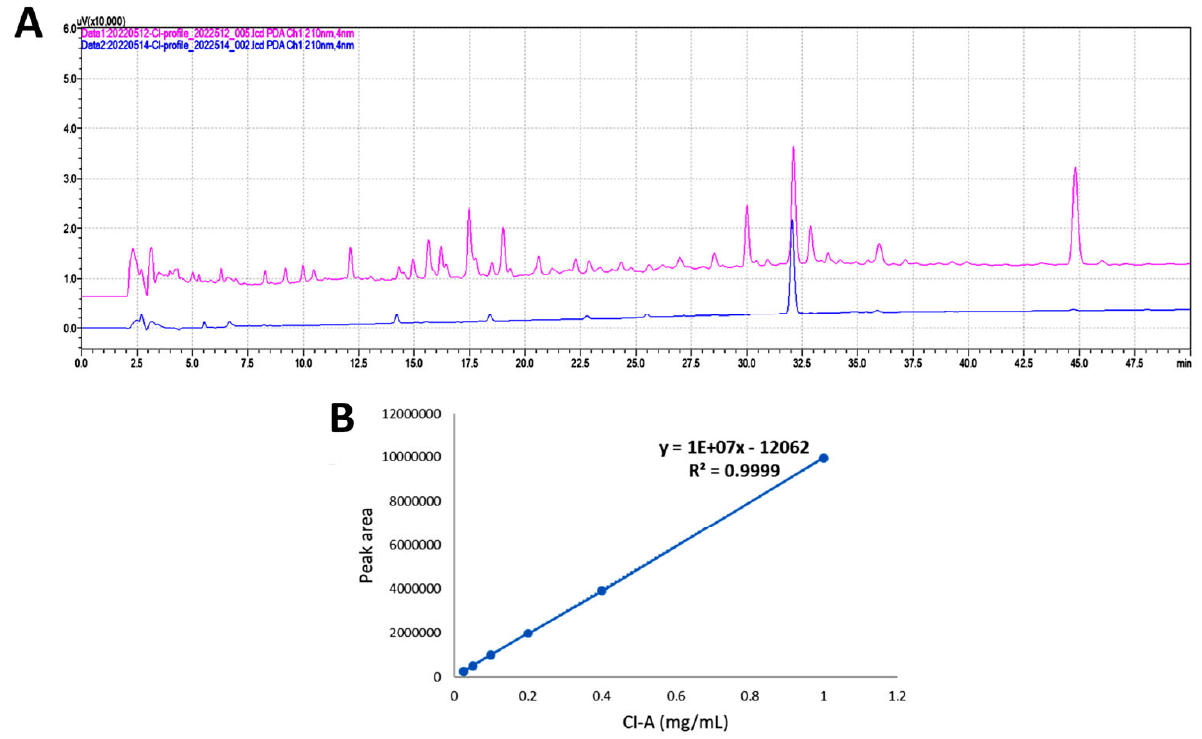
Figure 1. HPLC profile of MECI and major component. ( A ) The HPLC-UV (210 nm) fingerprint profile of MECI and (1 R *,12 R *)-dolabella-4(16),7,10-triene-3,13-dione are shown in red and blue, respectively. ( B ) The calibration curve of (1 R *,12 R *)-dolabella-4(16),7,10-triene-3,13-dione, namely CI-A ( n = 3).